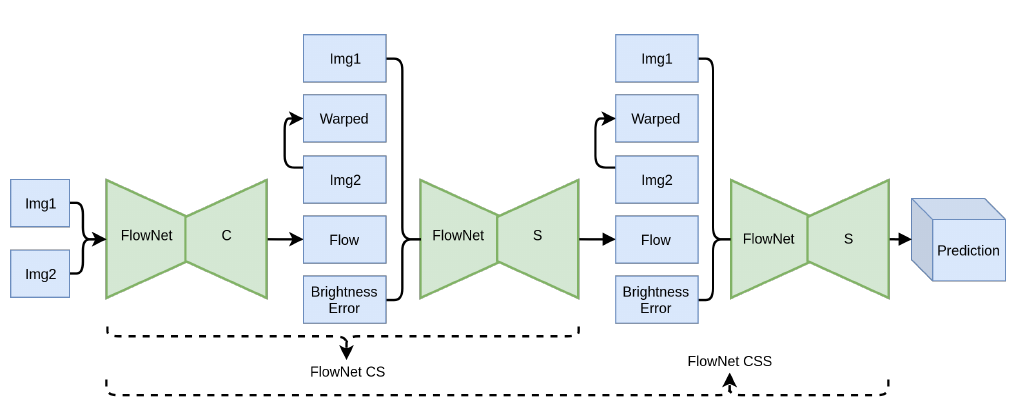
Figure 13. Overview of the network architecture. We utilize three stacked autoencoder refinement